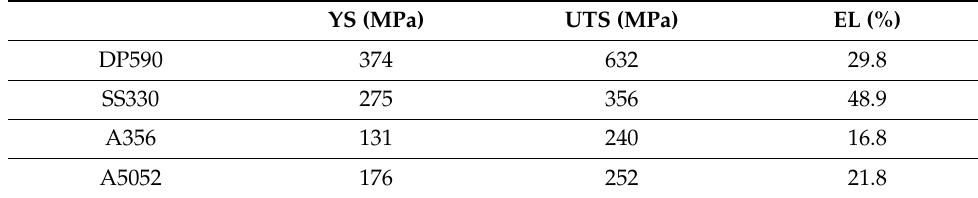
Figure 4. Stress–strain curves of the single ( a ) DP590, ( b ) A356, ( c ) SS330, and ( d ) A5052. Table 2. YS, UTS, and EL of each single material.